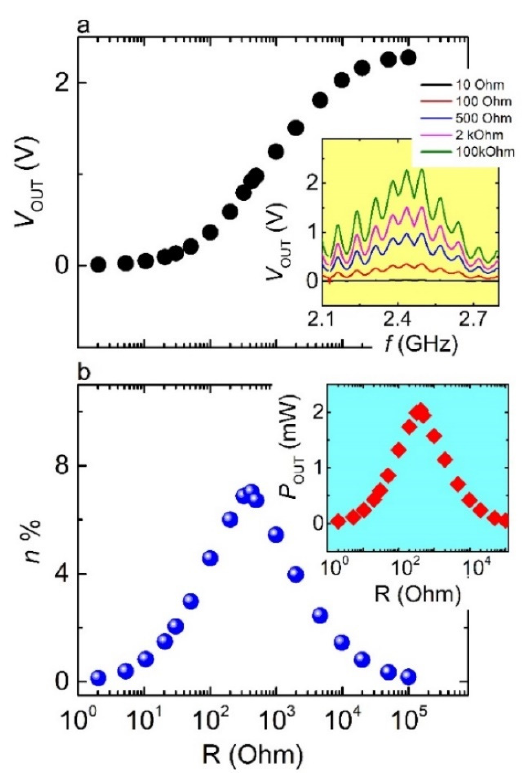
Figure 9. ( a ) Output voltage vs. resistance load, for the Electrifi MS, yellow inset: V OUT as a function of frequency for the selected resistance loads; ( b ) MS harvesting efficiency as a function of resistance load. A clear maximum is obtained for R ~400 Ohm, blue inset: P OUT as a function of R. Local maximum appears for R ~400